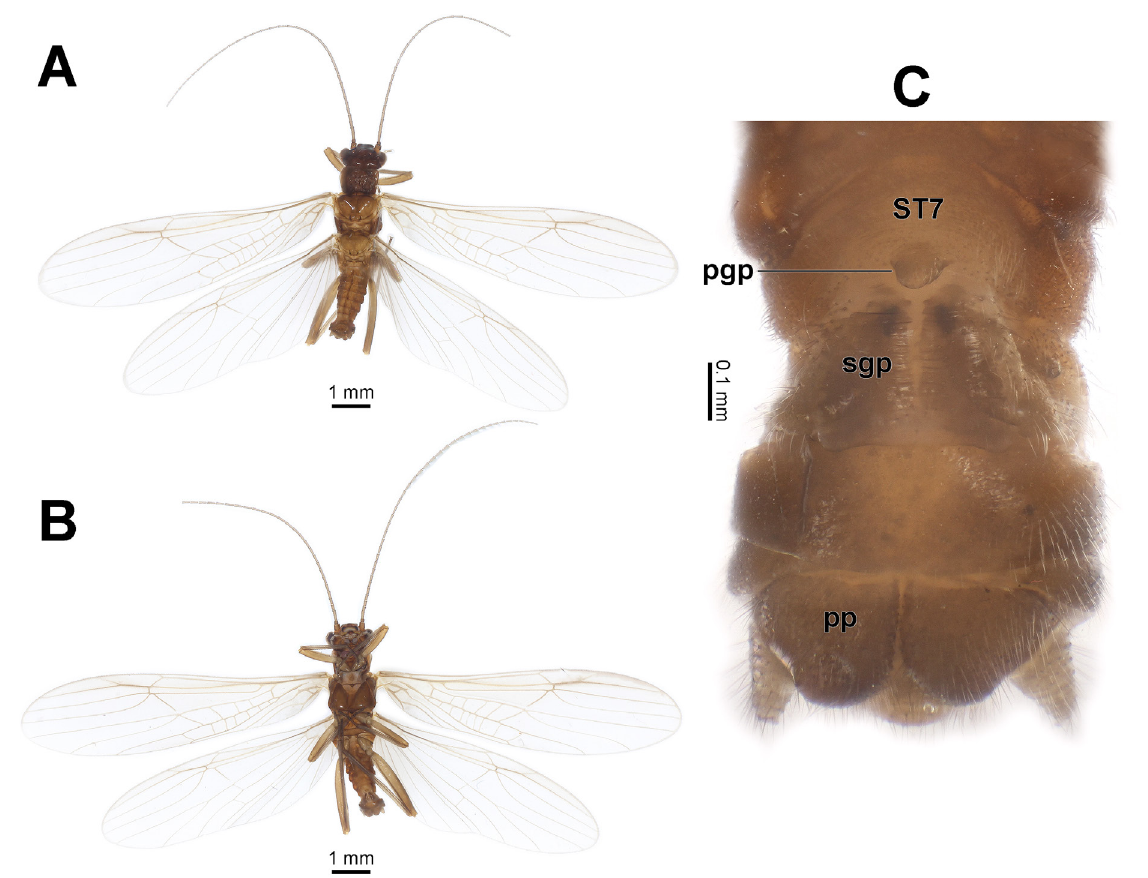
Fig. 11. Amphinemura jiaoheensis sp. nov. A . Female habitus, dorsal view. B . Female habitus, ventral view. C . Female terminalia, ventral